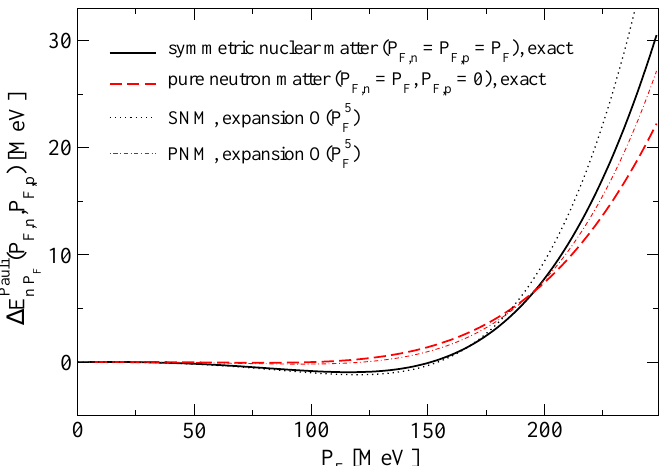
Figure 1. Exact Pauli-shifts for symmetric nuclear matter (solid line) and pure neutron matter (dashed line) as function of the Fermi momentum, together with their power law expansion up to O ( P 5 and dash-dotted thin lines,